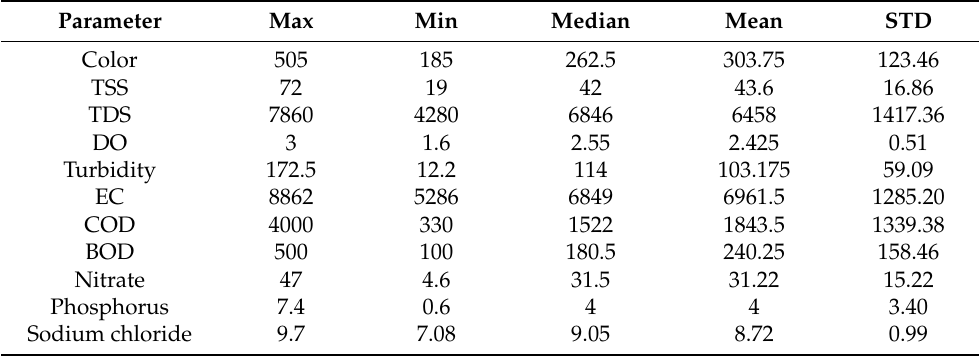
Table 3. Water quality characteristics from the samples collected from 0.5 m column